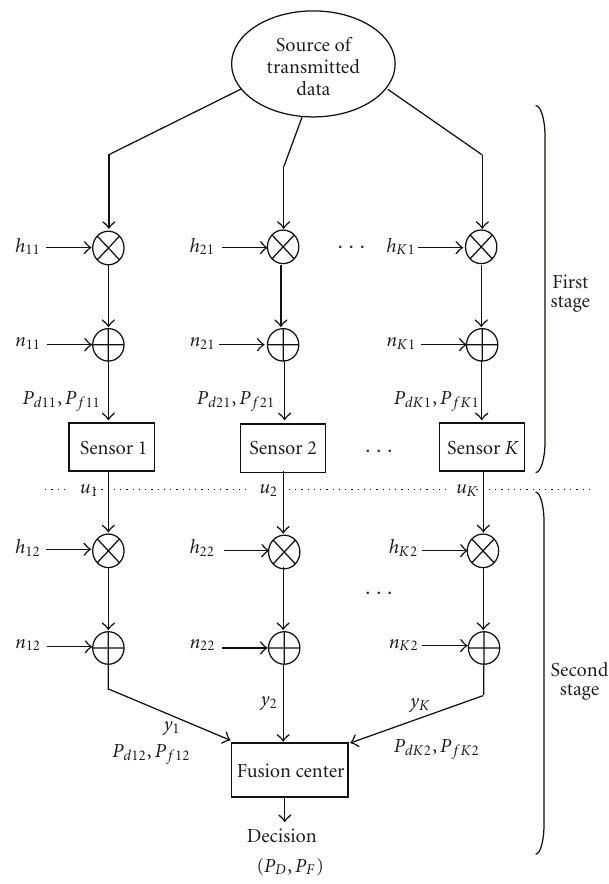
Figure 1: The two stage system